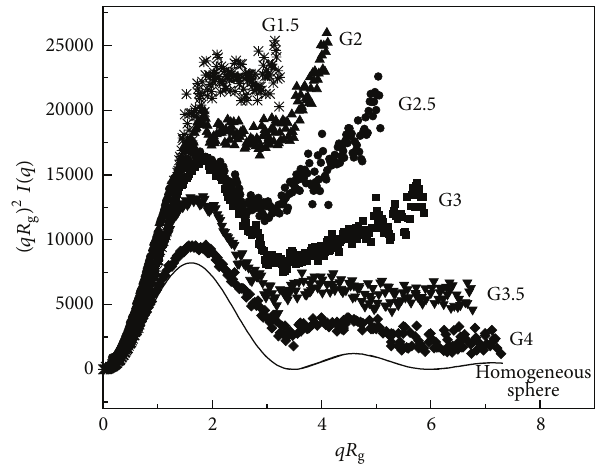
Figure 3: Kratky representation of the form factor corresponding to different generation of PAMAM dendrimers in methanol solution at the concentration of 𝐶 = 1